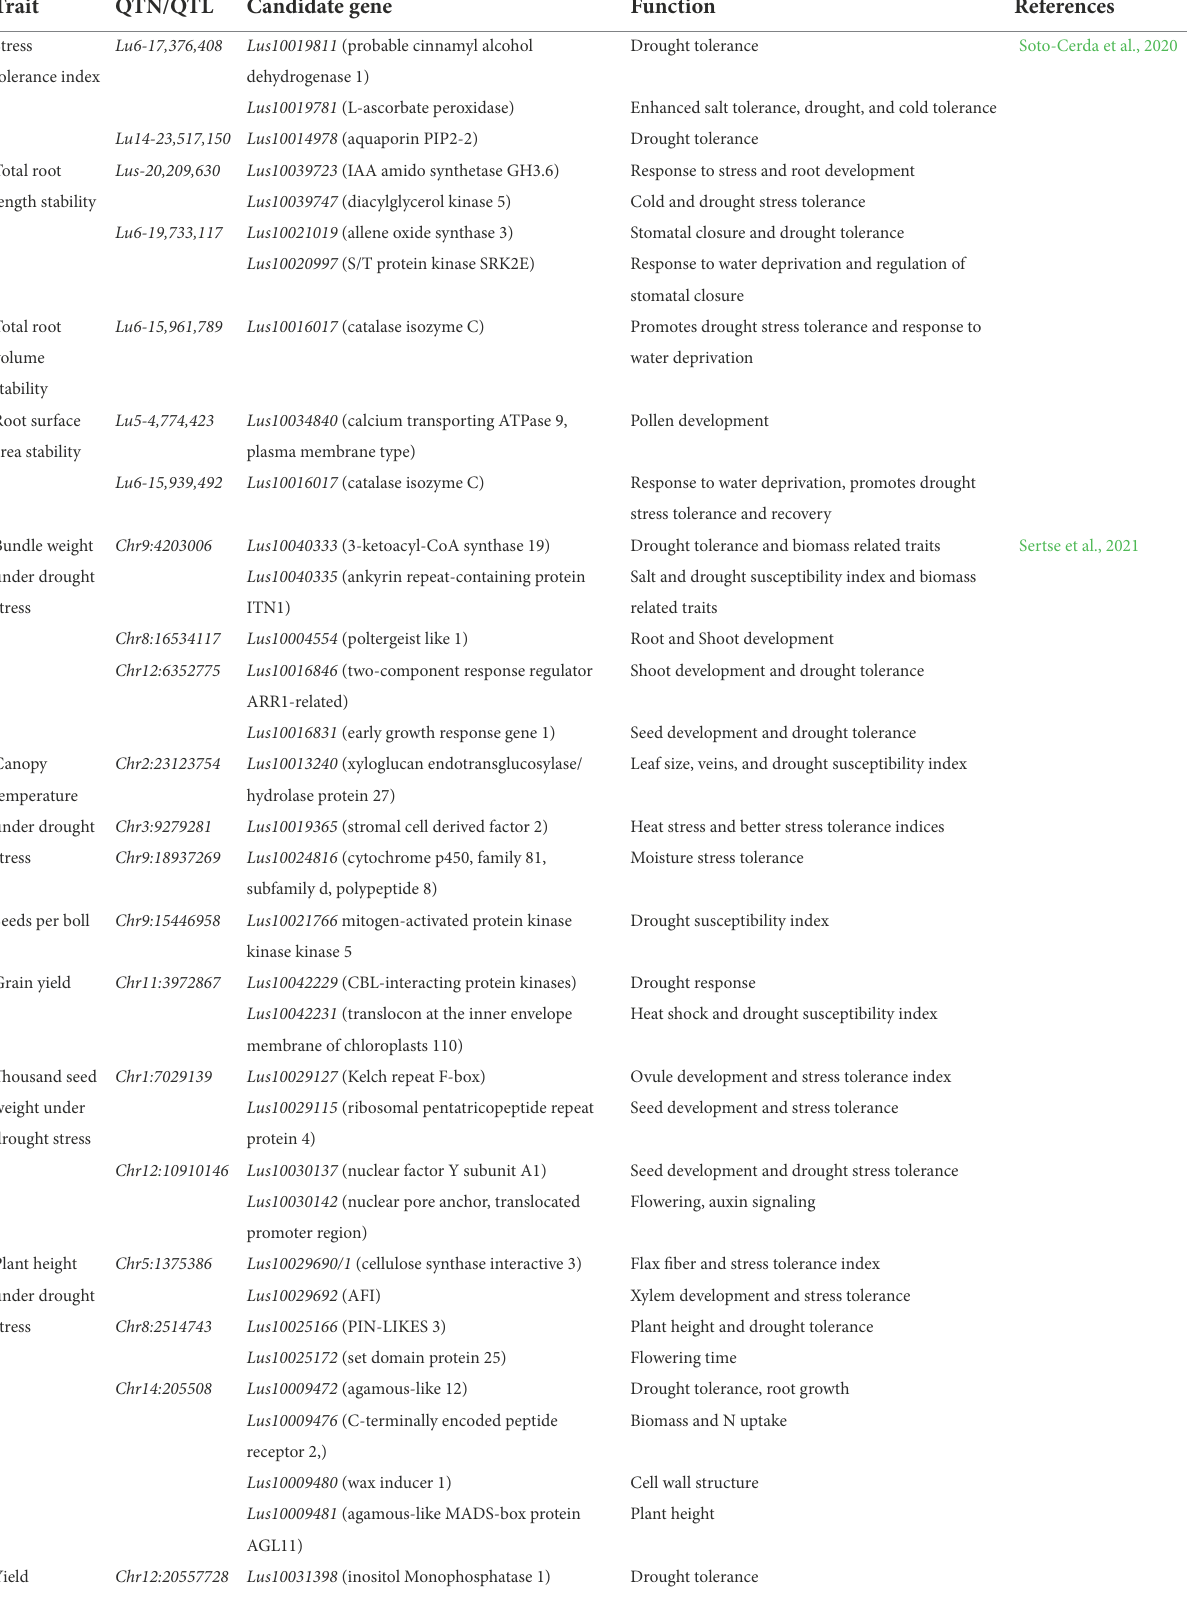
TABLE 1 Quantitative trait nucleotides/loci identified by Genome wide association studies for major abiotic and biotic stresses in flax. Trait QTN/QTL